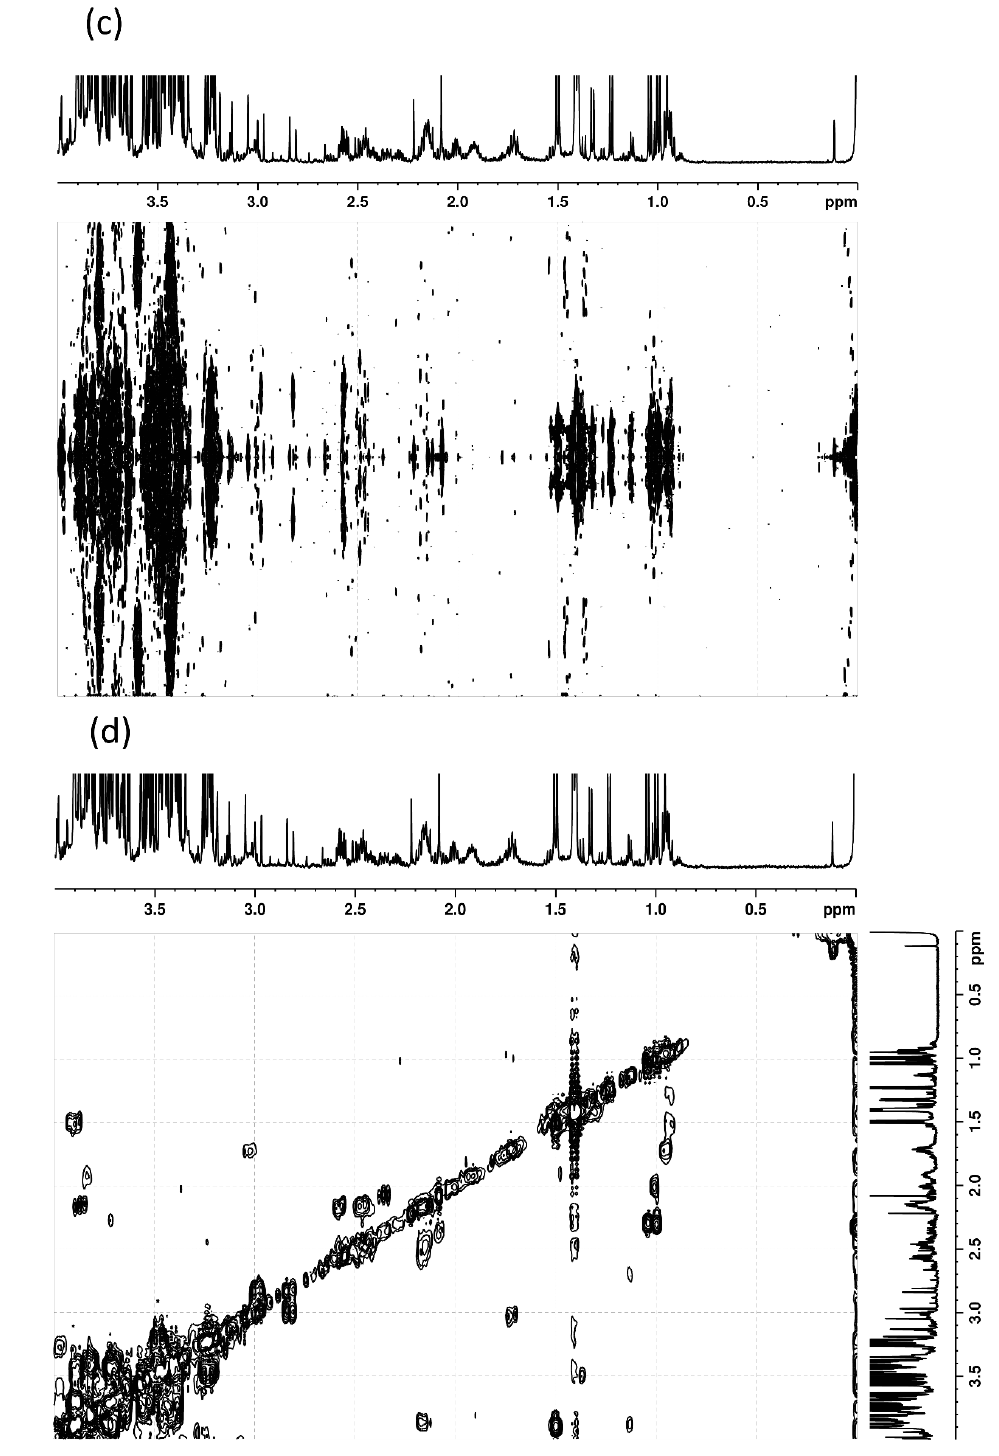
Figure 3. The identification of metabolites from NMR signals. After significant differences were detected and observed directly in spectra ( a ), spiking experiments were carried ( b ) out to validate assignments performed by means of 2D NMR experiments, namely J-resolved ( c ) and correlation spectroscopy ( d